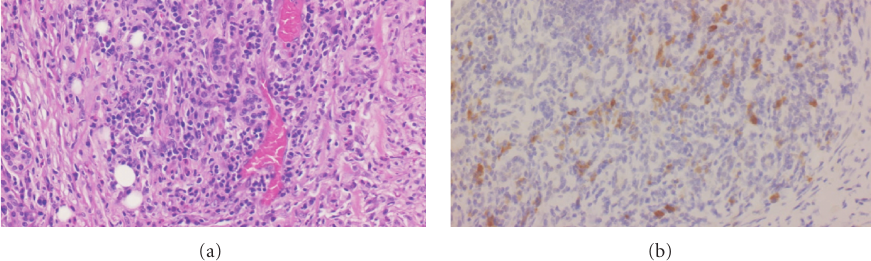
Figure 3: Histopathological examination of Case 2. (a) Small-sized gland ducts with plasma cell and eosinophilic leukocyte infiltrations (H&E stain × 40). (b) IgG4-positive plasma cells (stained with IgG4 monoclonal antibody × 40). Mouse monoclonal antibody to human IgG4 (clone, HP6025; dilution, 1:100; Zymed Laboratories Inc., Calif, USA). Table 1: Summary of three case